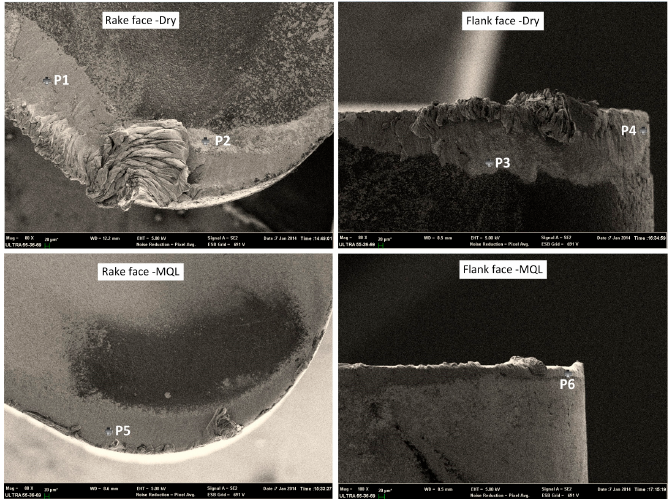
Figure 6. SEM images of carbide insert under dry and MQL conditions.